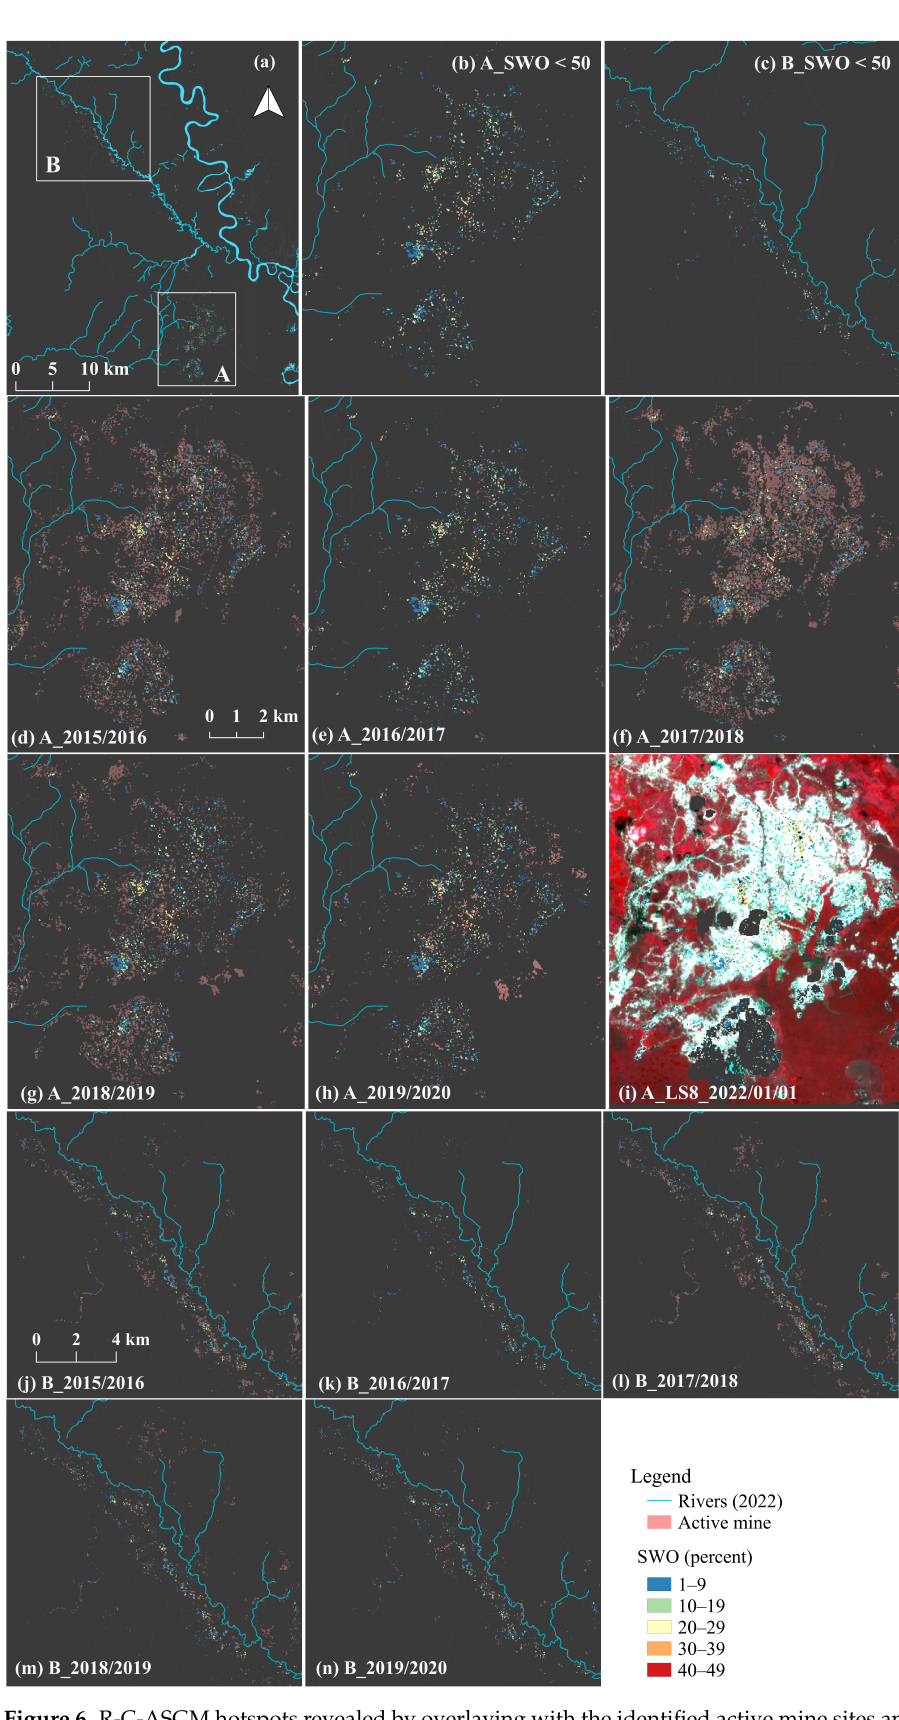
Figure 6. R-C-ASGM hotspots revealed by overlaying with the identified active mine sites and SWOs: ( a ) regional overview of SWO < 50 and waterbodies; ( b ) Galangan area ( A ); ( c ) Kalana-man area ( B